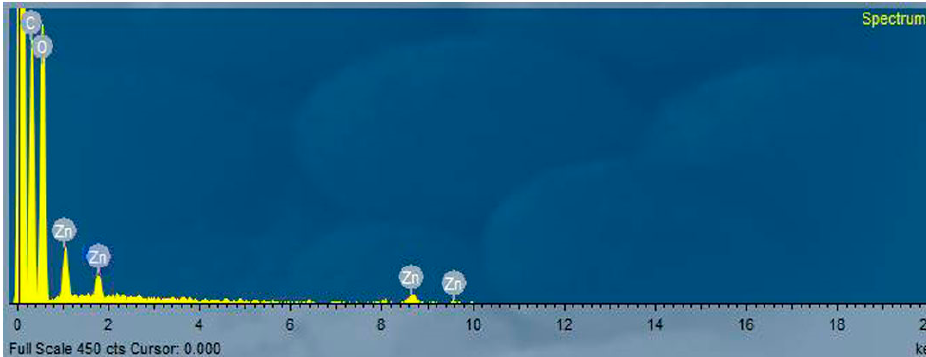
Figure 7. EDX of the PRD/Zn metal complex.